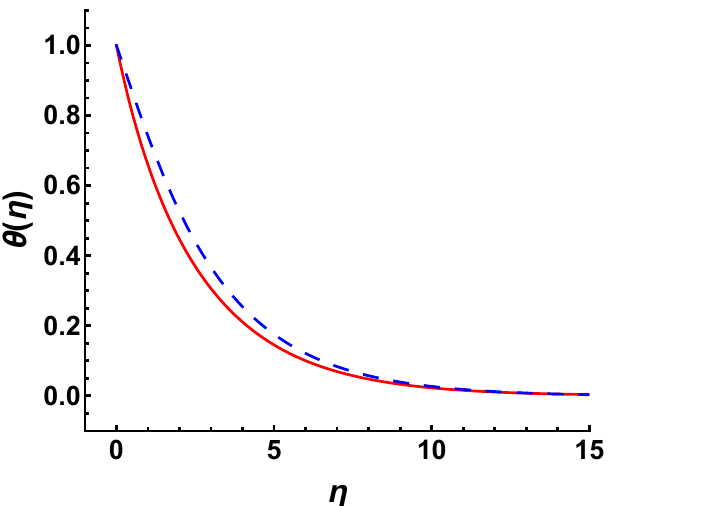
Figure 7. Temperature profile for different wall temperature conditions in the cases of γ = 0.3, Pr = 0.2, M = 2 and s = 3. Long-dashed line: Tw = T ∞ + T 0 e x 2 L ; solid line: Tw = T ∞ + T 0 .